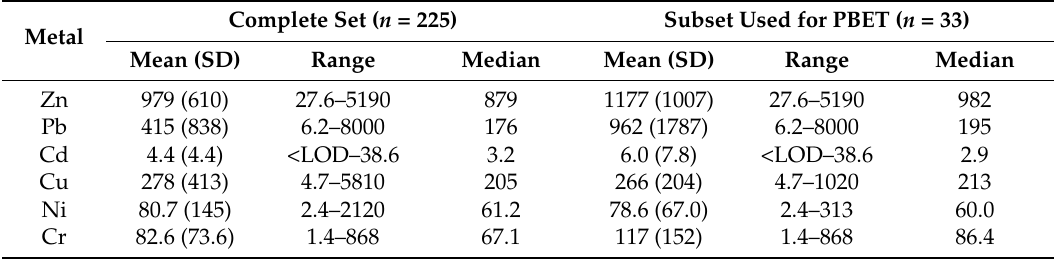
Table 1. Statistical summary of total metal concentrations (mg/kg) in the complete set of house dust samples from 225 Montreal homes and the subset of 33 house dust samples selected for Physiologically Based Extraction Technique (PBET) extractions in the present study (<80 µ m fraction). SD = Standard deviation; LOD = Limit of